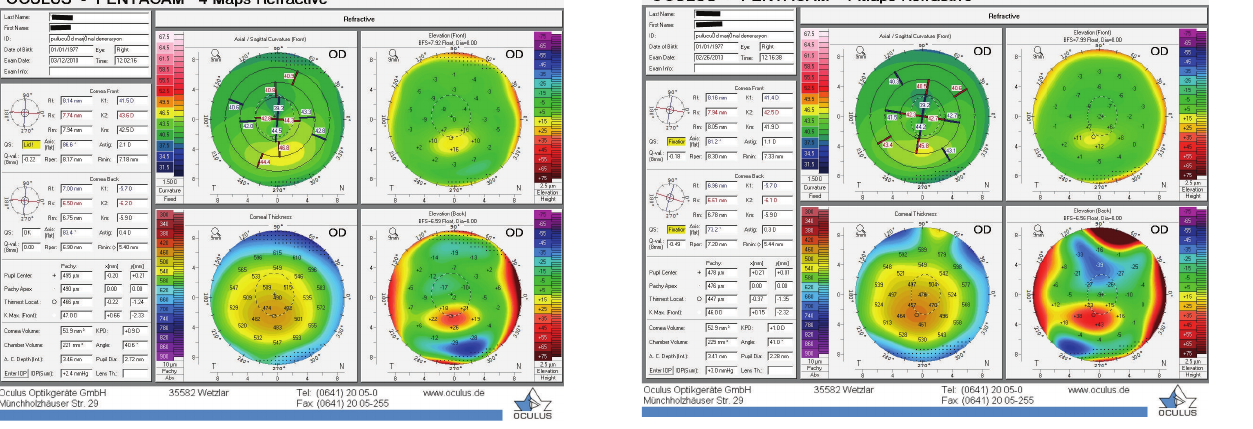
Figure 5: Patient 2, right eye before the treatment.